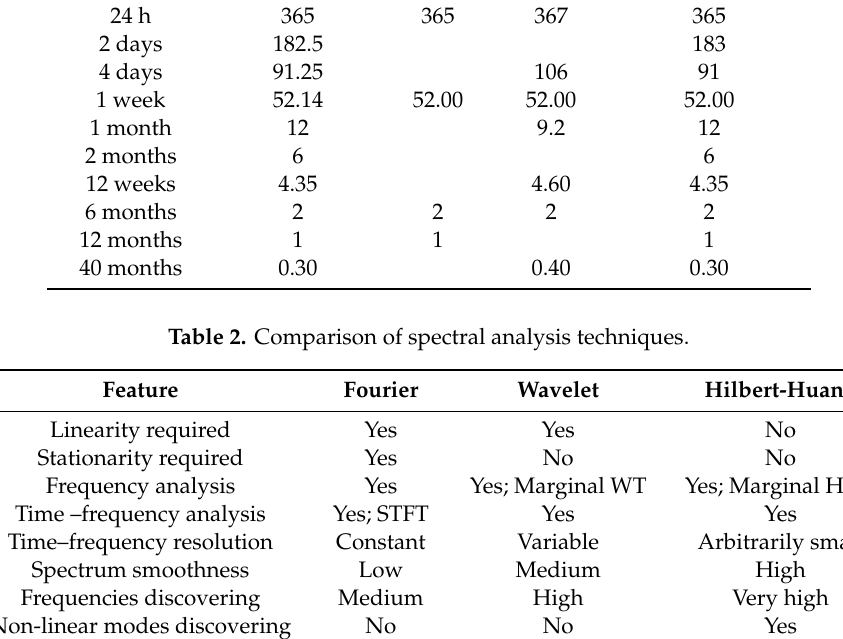
Table 1. Frequencies discovered for different spectral analysis methods.